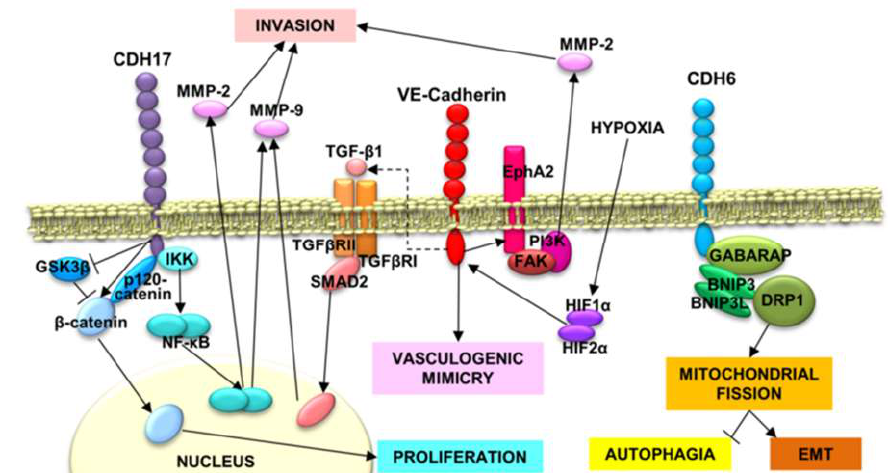
Figure 1. Cancer-related signaling pathways involving RGD cadherins. CDH17-triggered phosphorylation of I κ B Kinase (IKK) causes NF- κ B release and translocation to the nucleus, where it promotes the